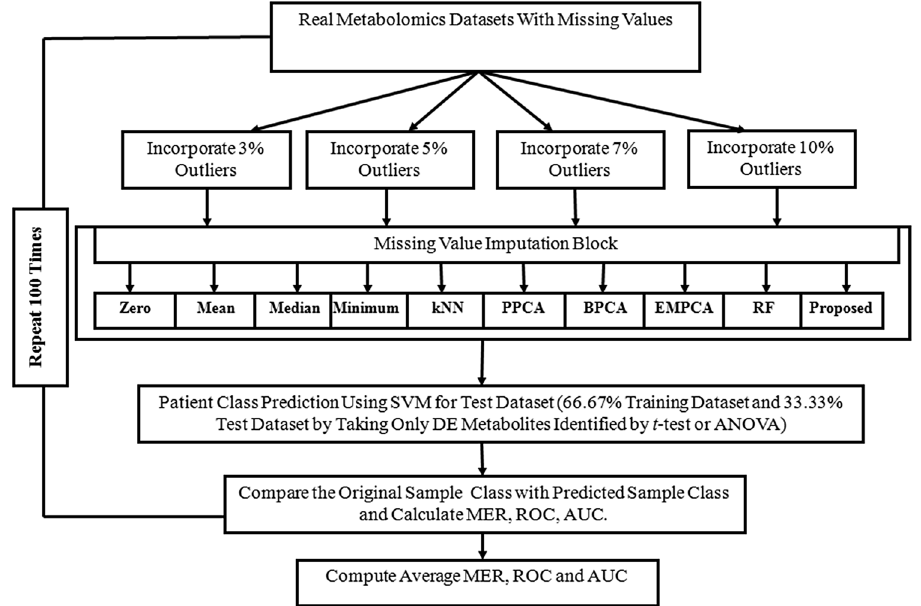
Figure 5. Performance measures calculation procedure for real dataset on the basis of sample classification.